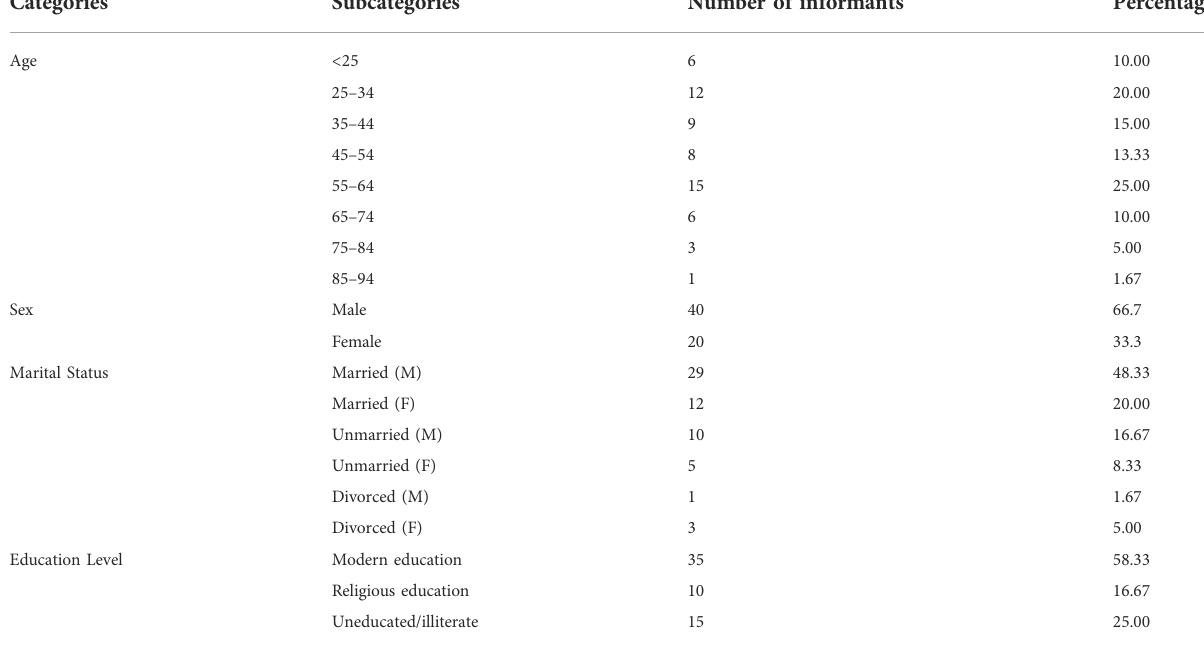
TABLE 1 Socio-demographical information of the traditional